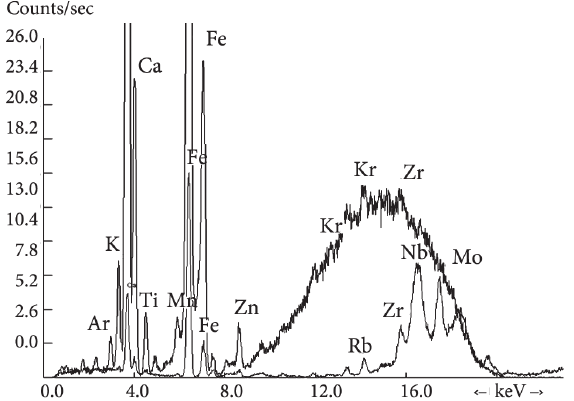
Fig. 3. Niton XL2 window showing wavelength and intensity